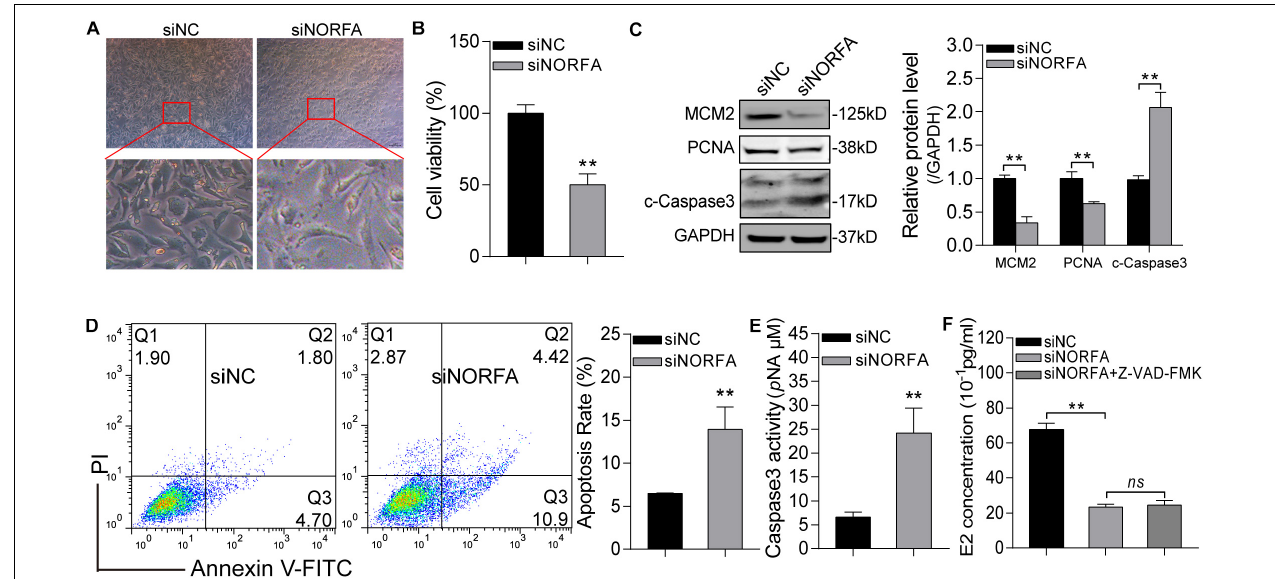
FIGURE 8 | Knockdown of NORFA impairs the normal states and functions of porcine GCs. (A) The morphological features of control and NORFA -reduced porcine GCs were observed and recorded by a stereomicroscope. (B) Cell viability in control and siNORFA treatment group was measured by CCK-8 reagent at the 48-h point. (C) The effects of NORFA reduction on the protein level of MCM2, PCNA, and cleaved-Caspase3 (c-Caspase3) in porcine GCs were determined by Western blotting. (D,E) Porcine GCs were transfected with siNORFA for 48 h, and then cell apoptosis rate (D) and Caspase3 activity (E) were measured. (F) The concentration of E2 in porcine GCs after treatment with siNORFA or siNORFA with 50 µ M Z-VAD-FMK (a pan-caspase inhibitor) was detected. Data were represented as mean ± S.E.M., and P values were calculated by a two-tailed Student’s t test with three independent replicates. ** P < 0.01 and ns indicates no